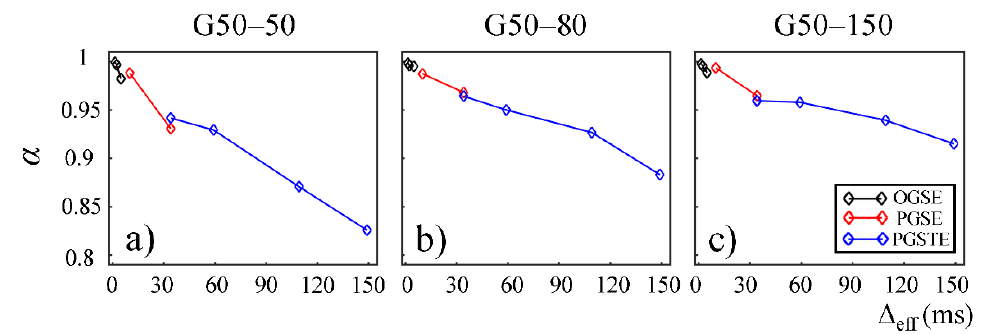
Figure 7. Plot of temporal fractional order ( α ) versus effective diffusion time, Δ eff , for gels G50 – 50 ( a ), G50 – 80 ( b ), and G50 – 150 ( c ). The data acquired by using the OGSE, PGSE, and PGSTE pulse sequences are marked in black, red, and blue, respectively.